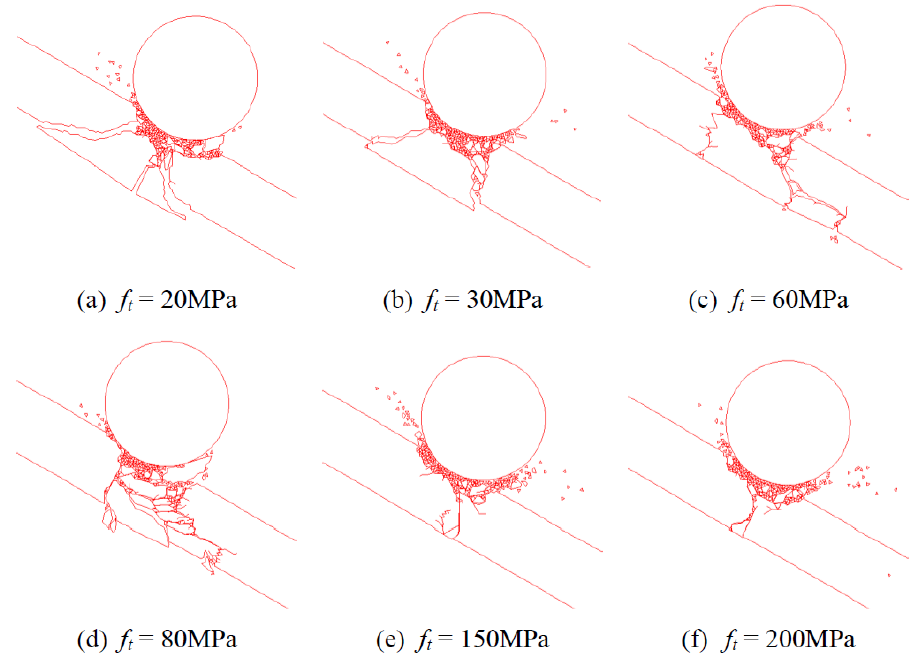
◦ , v = 5 m/s and different f Figure 19. Fracture patterns of the glass with α = 60°, v = 5 m/s and different ft at t = 1 ms. Figure 19. Fracture patterns of the glass with α = 60 t at t = 1 ms. As a comparison, the fracture patterns of the same glass beam subjected to perpen- dicular impact are shown in Figure 20. When f t ≤ 100 MPa, a cone crack can be clearly seen, as shown in Figure 20a–c. It is worth mentioning that with the increase of f t , spalling damages around the impact point get more and more serious, as shown in Figure 20b,c, though cone cracking is still dominant. When f t > 100 MPa, the impact resistance of glass is so high that no cone can be observed, and only spalling is obtained (Figure 20d–f). Based on the analyses above, the failure modes of both 60 ◦ oblique impact and 90 ◦ perpendicular impact are summarised in Table